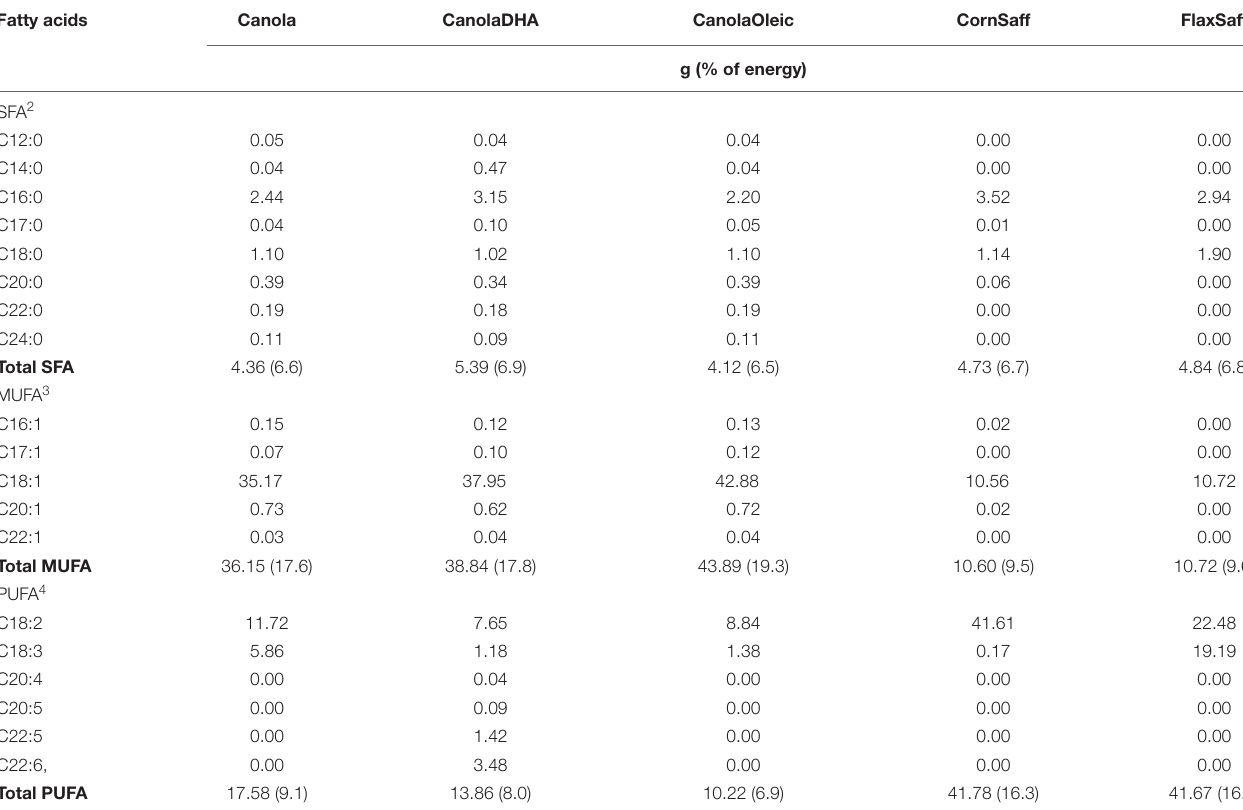
TABLE 1 | Fatty acid composition of five dietary oil treatments 1 (g) consumed at 60 g/d (35% of energy intake based on 3000 kcal/d). Fatty acids Canola CanolaDHA CanolaOleic CornSaff